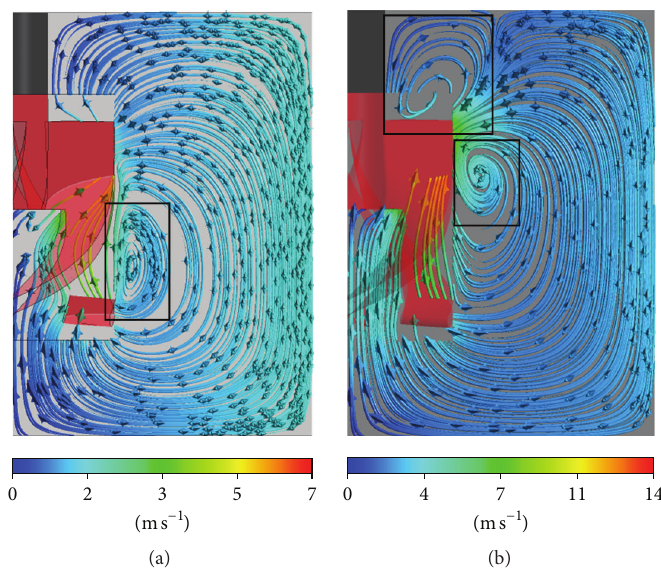
Figure 8: Velocity streamlines in 11.46% unbleached kraft pulp: (a) 𝑁 = 800 rpm and (b) 𝑁 = 1800 rpm. (3) The number and location of vortexes and streamlines were analyzed for different mass concentrations and